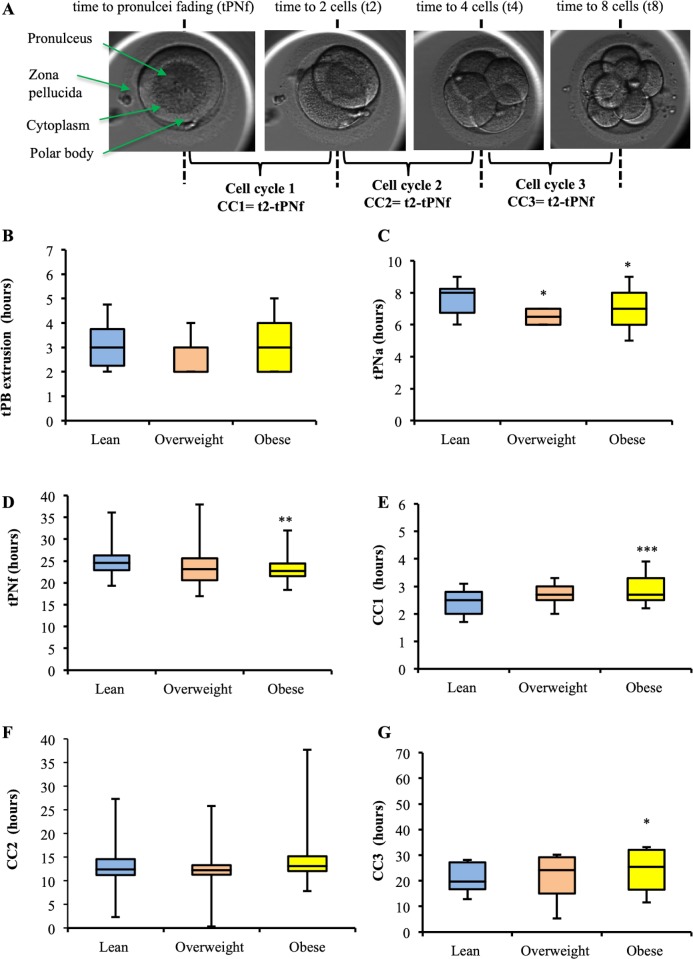
Effect of obesity on the morphokinetic parameters of pre-implantation embryo development.(A) Pictures of pre-implantation embryo development. Boxplots presenting the results expressed as median ± interquartile range for (B) the time of the second polar body extrusion (tPB extrusion), (C) the time when the first pronuclei is condensed and visible (pronuclei appearance, tPNa) (D), the time when both pronuclei disappear (tPNf) (E), the length of the first embryonic cell cycle (CC1 = time to 2 cells (t2)-(tPNf), (F) the length of the second embryonic cell cycle (CC2 = time to 4 cells (t4)-(t2)), and (G) the length of the third embryonic cell cycle (CC3 = time to 8 cells (t8)-(t4)) in the embryos derived from normal (blue boxplots), overweight (pink boxplots), and obese (yellow boxplots) fathers. Stars indicated groups that are statistically significantly different from the lean group (*p<0.05, **p<0.01, ***p<0.001).